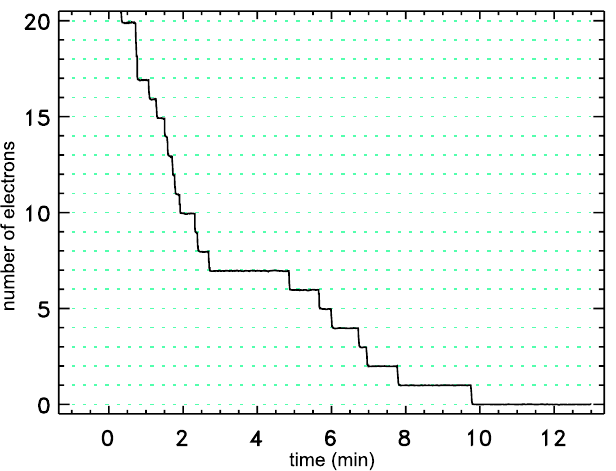
FIG. 14. (Color) Proportionality factor between bending magnet current and magnetic